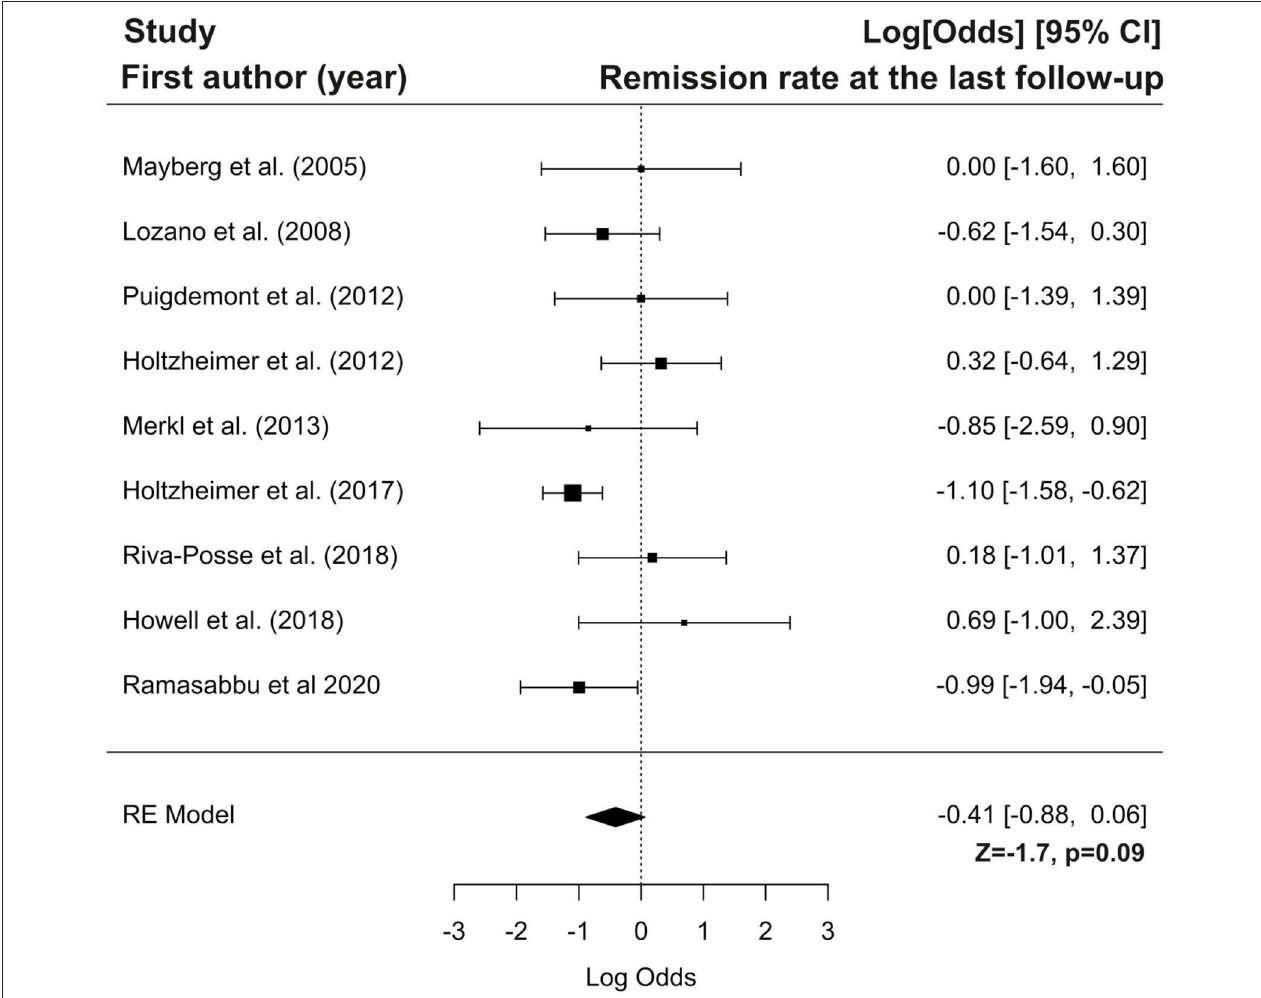
FIGURE 4 | Forest plot showing logit-transformed proportions for remission rate at the last